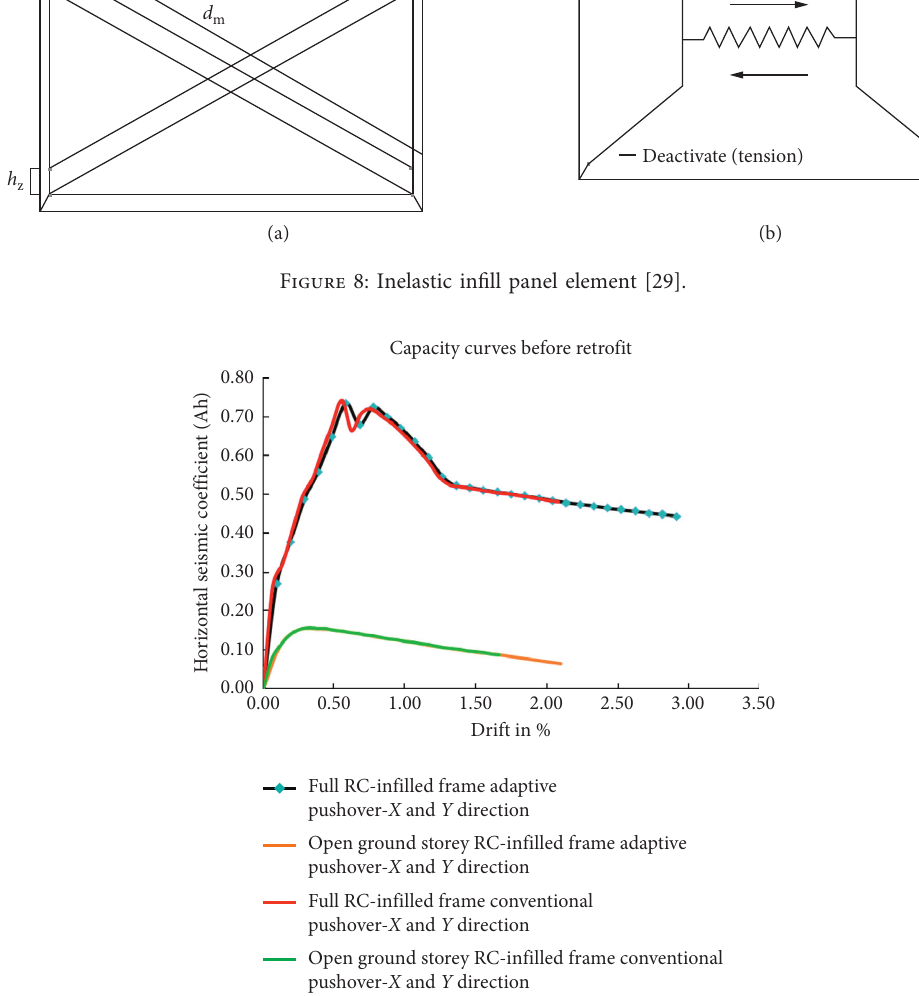
Figure 9: Pushover curves of different frames before the retrofit. Table 5: Comparison of different parameters for the full RC-infilled